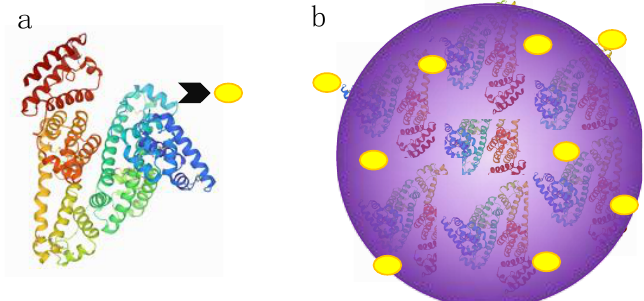
Figure 2. Simplified preparation methods of two different approaches to albumin-based drug delivery systems: ( a ) drug-conjugated albumin and ( b ) drug-containing NPs.